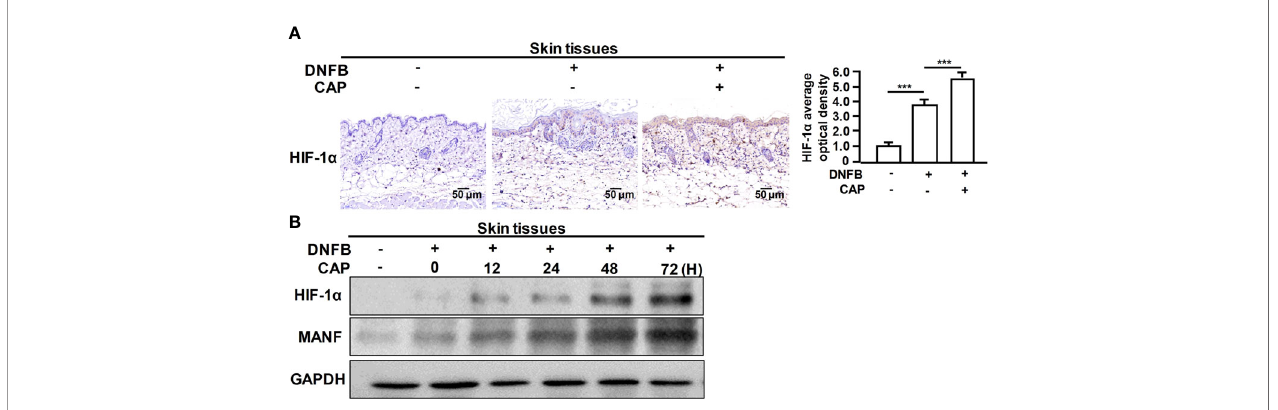
FIGURE 4 | CAP treatment signi fi cantly enhanced DNFB-induced HIF-1 a expression in skin tissues. DNFB-induced AD mice model was constructed, followed by CAP treatment, n=8. (A) Skin tissues (n=5) were used for immunohistochemical staining of HIF-1 a . The average optical density was analyzed. (B) At 0, 12, 24, 48 and 72 hours after CAP treatment, skin tissues (n=5) were used for western blot of HIF-1 a and MANF. GAPDH serves as control for normalization. Data are expressed as mean ± SEM. ***p < 0.001.